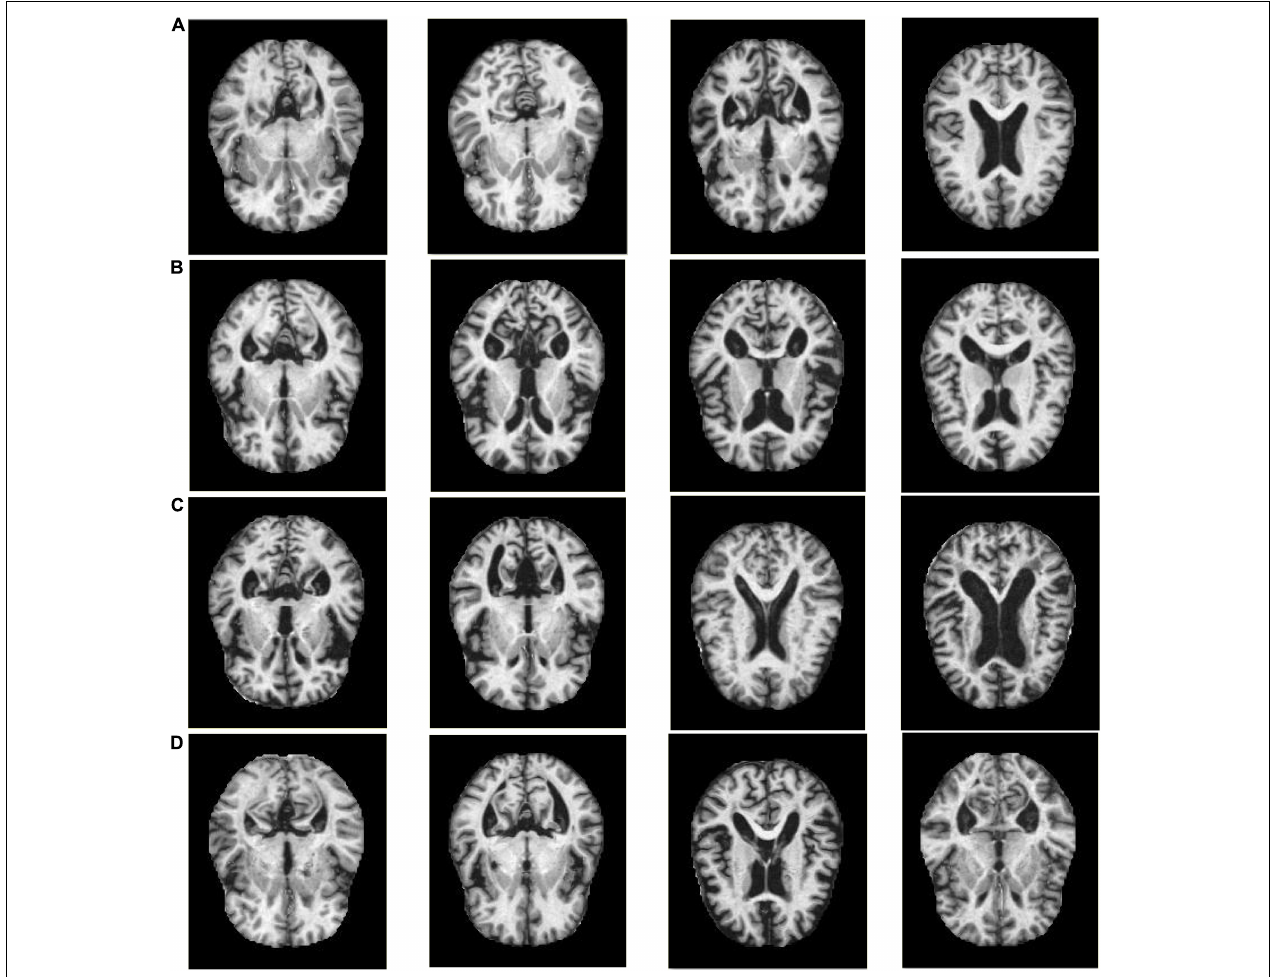
FIGURE 1 | Example samples of the KAGGLE Alzheimer’s dataset, (A) Non AD, (B) Moderate AD, (C) Mild AD, (D) Very Mild